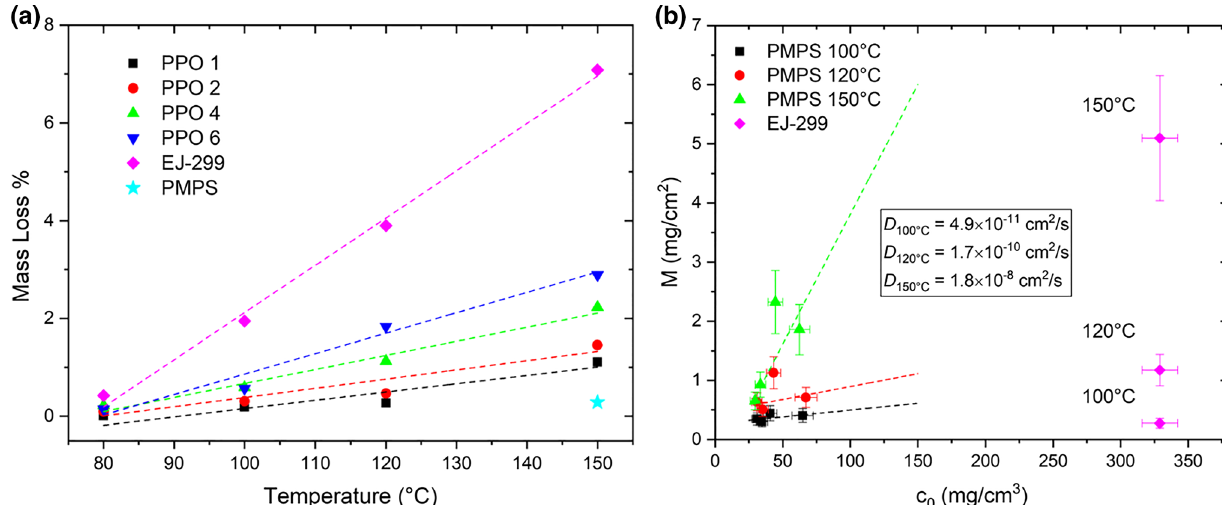
Fig. 2 a Mass loss % of PMPS based samples containing different amount of PPO, the standard EJ-299 and the bare PMPS treated at dif- ferent temperatures for 24 h; dashed lines represent the result of linear fit for each data set. b PPO mass loss versus starting PPO concentration,